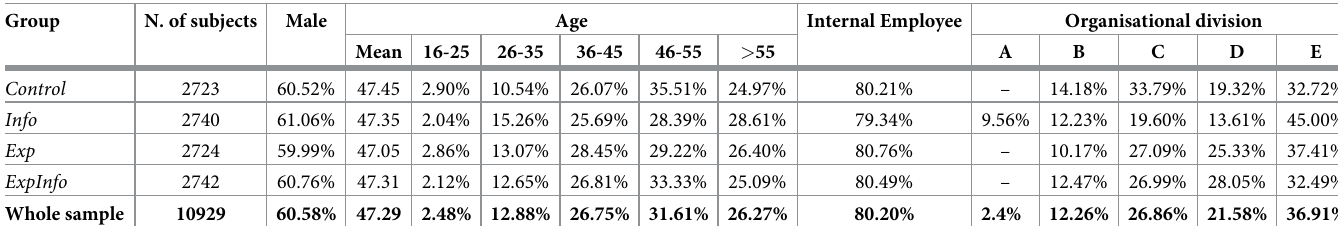
Table 2. Descriptive statistics.